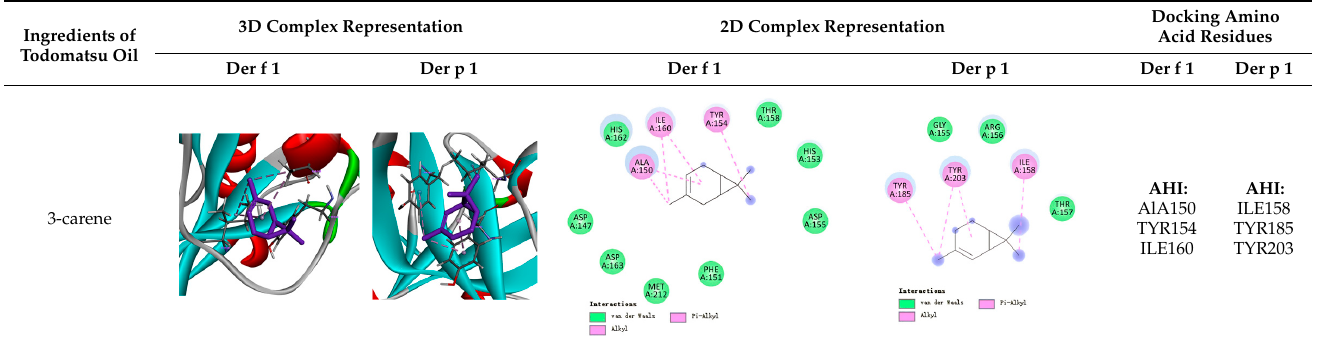
Table A1. 2D and 3D diagrams of ingredients-of-todomatsu oil (except top 5 ingredients) on allergens Der f 1(5vpk)/Der p 1(5vph) binding pocket.